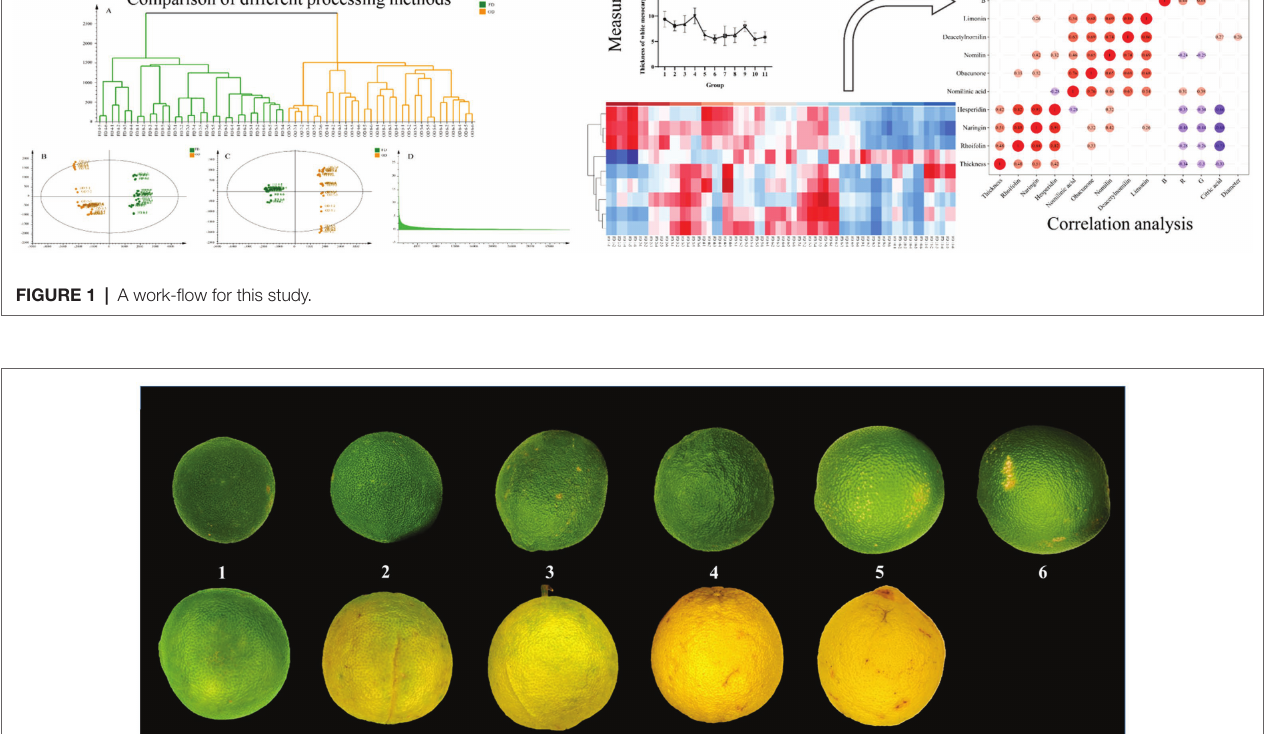
FIGURE 2 | Representative samples of Citrus wilsonii Tanaka